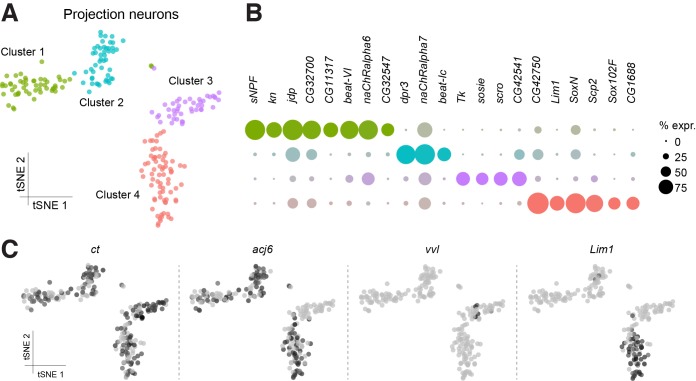
Sub-populations of olfactory projection neurons.(A) Re-clustering of the two Projection Neuron (PN) clusters from Figure 1B. Clusters are color-coded. (B) Dot plots showing the main markers distinguishing PN populations from each other (pairwise comparisons for genes expressed in >50% of cells in either cluster; Log2 FC >1.5, Wilcoxon rank-sum test with Bonferroni-corrected p-value<0.01). Dot diameter represents the fraction of cells expressing each gene in each cluster, as shown in scale. Color intensity represents the average normalized expression level. (C) t-SNE-plots for some known markers of PNs. ct labels all PN clusters, acj6 and vvl are mutually exclusive in Clusters 1, 2 and 4, versus Cluster 3, while Lim1 is specifically expressed in Cluster 4. Some of these cells may be antennal lobe local interneurons.